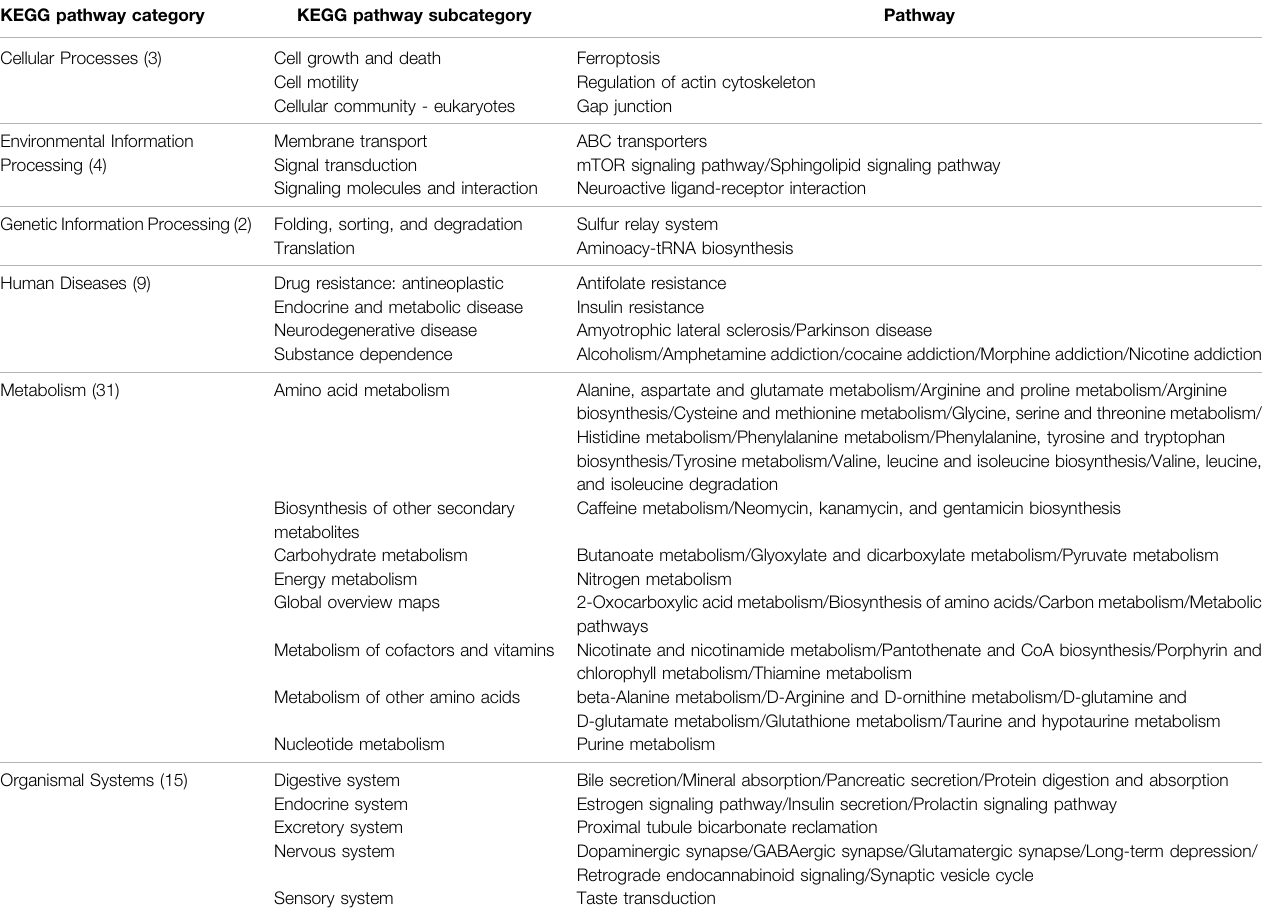
TABLE 3| Identi fi ed common pathwaysin HisCoM-SM and conventional HisCoM (q-value < 0.05). The pathways are categorized by KEGG pathway categories and KEGG pathway subcategories. The values in parenthesis are the number of pathways included in the KEGG pathway. KEGG pathway